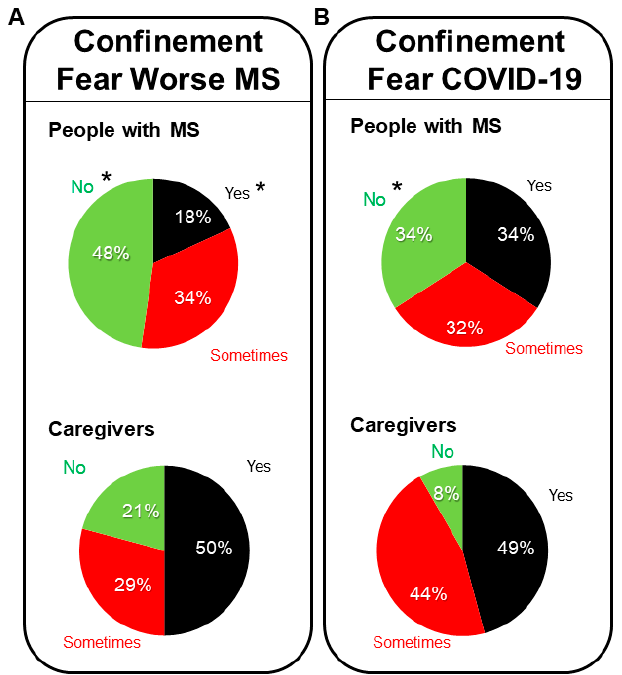
Figure 3. Confinement–fears of worsening of MS and COVID-19 related fears. Sample distribution of the people with MS and caregivers answering on their fears of MS being worsened during the confinement ( A ), and fears about getting infected and ill with COVID-19 ( B ). Statistics: Fisher’s test or Chi-square, * p < 0.05 people with MS vs. caregivers.